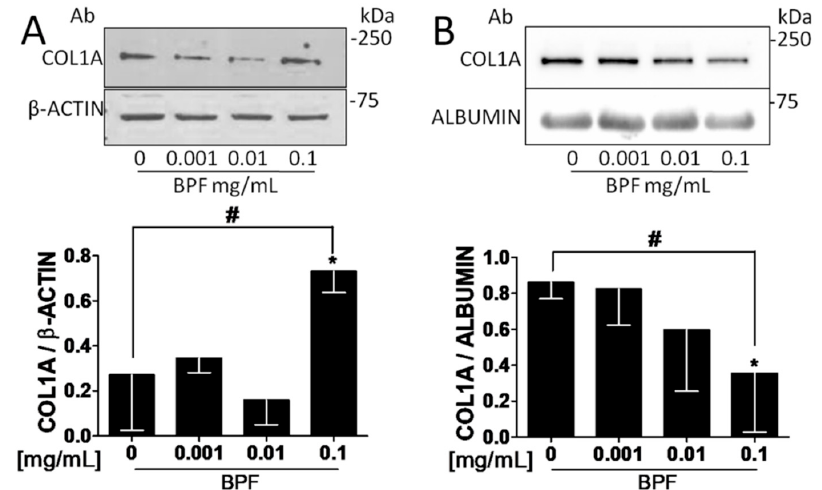
Figure 4. BPF increases intracellular COL1A protein levels and decreases extracellular COL1A protein levels on Saos-2 cells. Semi-confluent cultures of human osteoblast-like cells (Saos-2) were incubated with BPF 0.001-0.01-0.1 mg/mL for 24 h. Cell and medium proteins (( A , B ) respectively) were analyzed by Western blotting, with antibodies specific to COL1A, β -actin and Albumin. Data are represented as mean ± SD. Statistical analysis: Student’s t -test vs. 0 * p < 0.05. Linear regression # p < 0.05. Abbreviations: BPF, Bergamot Polyphenol fraction; COL1A, Type 1A collagen.